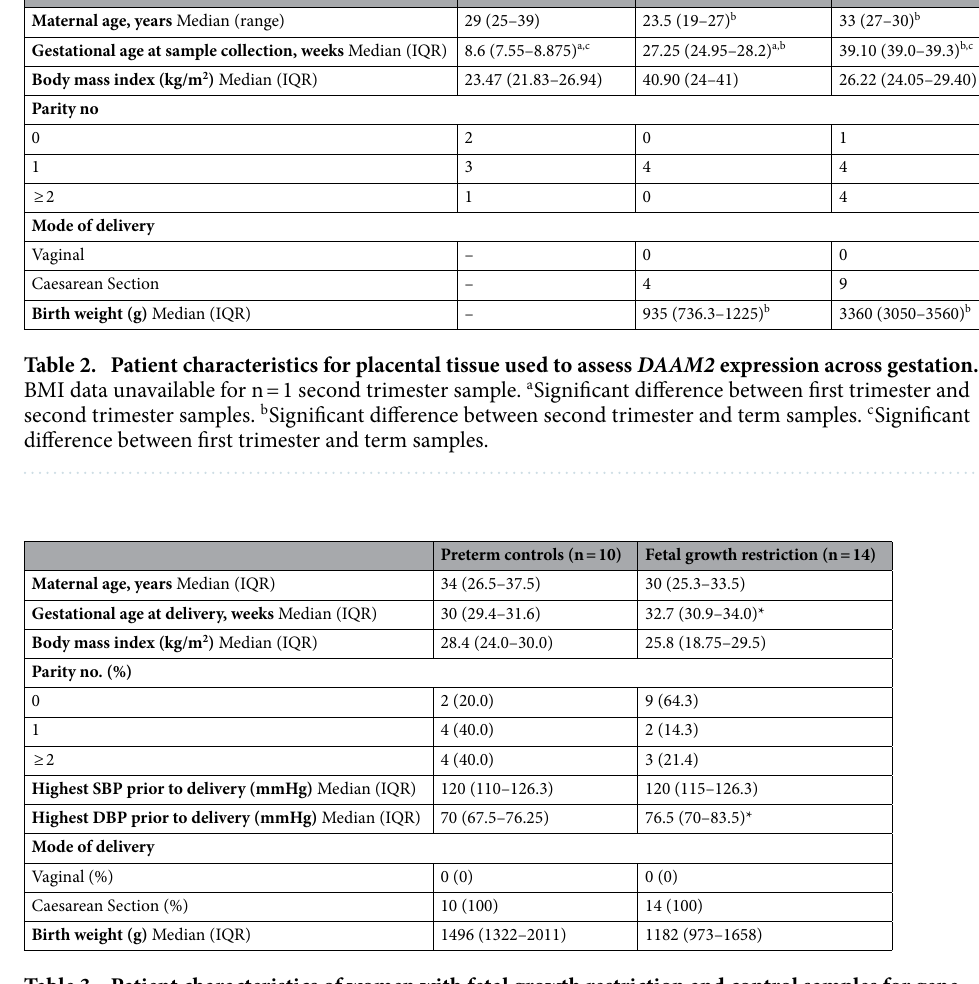
Maternal age, years Median (IQR)